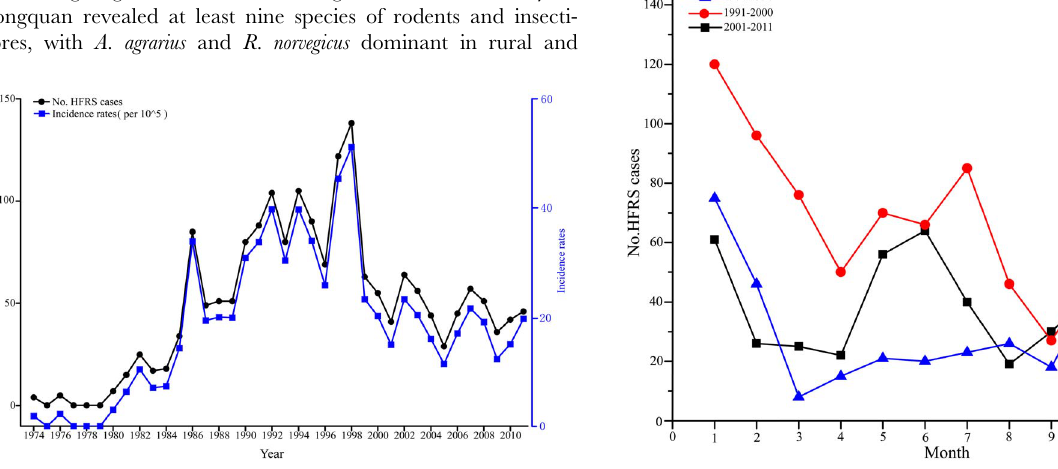
Figure 2. The monthly distribution (seasonality) of HFRS cases in Longquan. The seasonal distribution of HFRS cases during the period 1974–2011 in Longquan city.